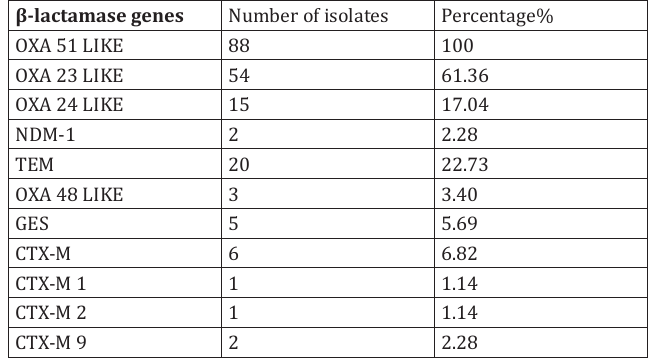
PCR result amplified β -lactamase genes in A. baumanii (88) isolates